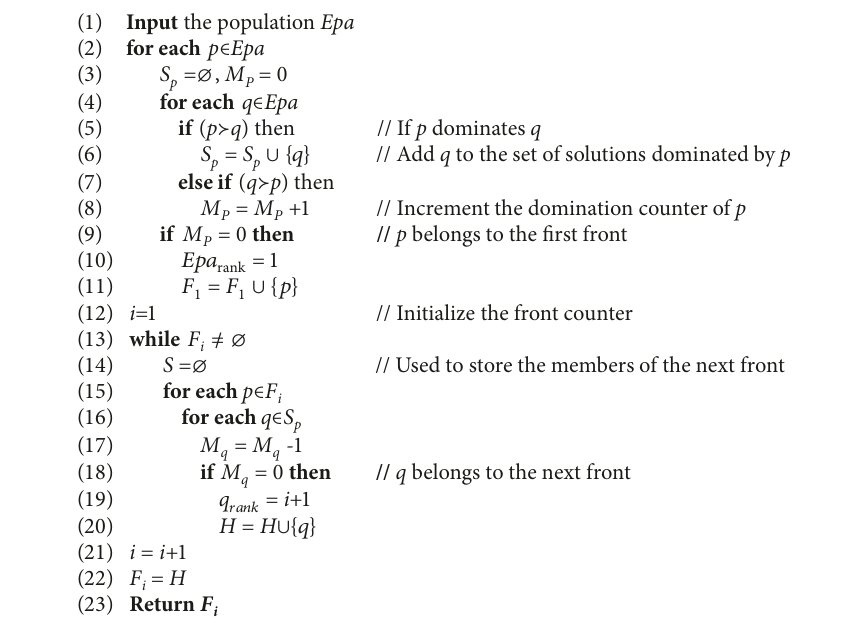
Algorithm 2: Fast Non Dominated Sort( Epa ).